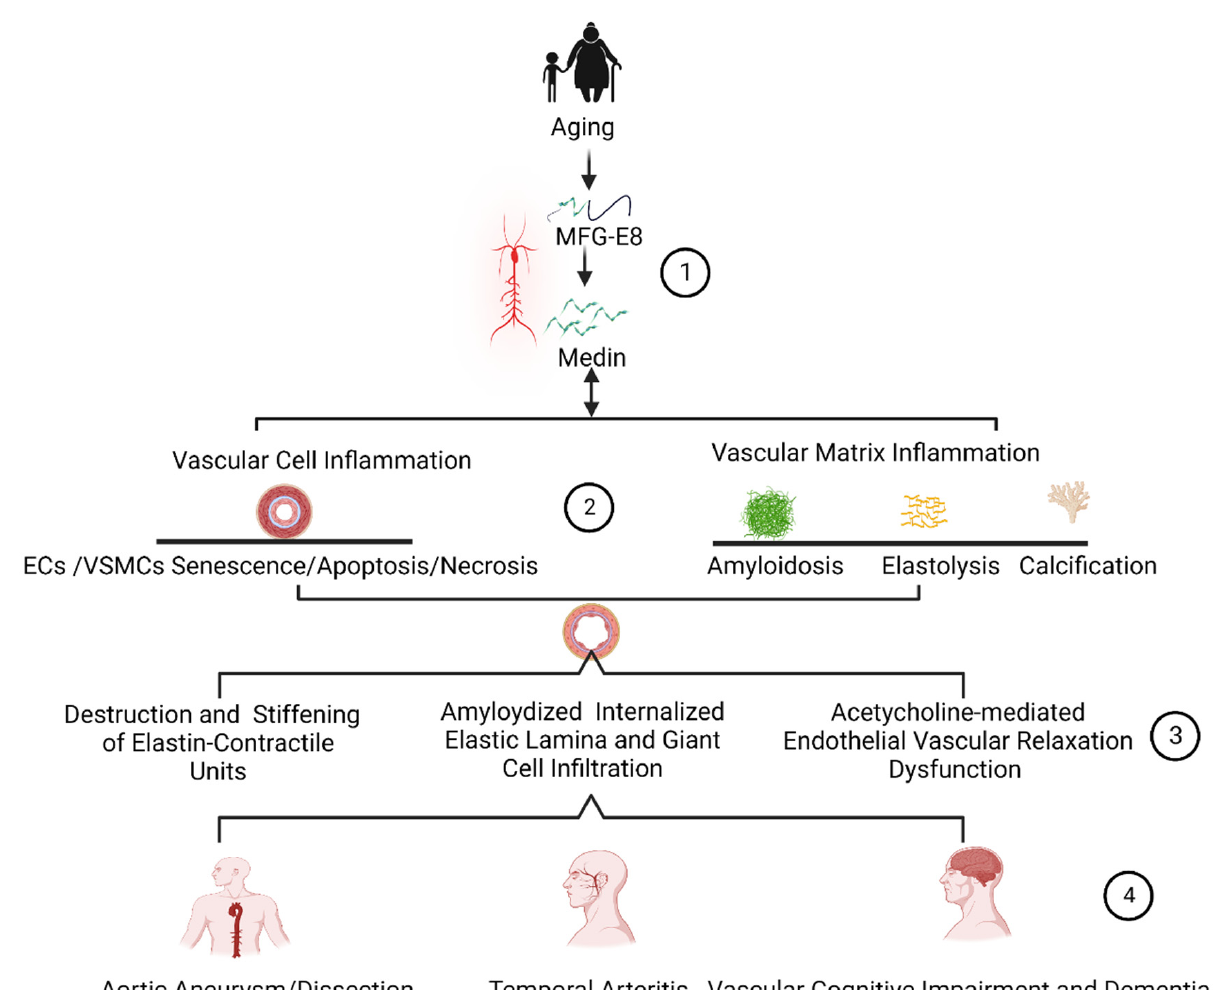
Figure 5. The Role of MFG-E8 Fragment Medin in Age-Associated Arterial Disease. (1) Aging increases MFG-E8 and its fragment medin during inflammatory remodeling; (2) Medin drives the inflammatory phenotypic shifts of ECs and VSMCs, and medin inflammation modifies the vascular extracellular matrix such as through amyloidosis, elastic fragmentation, and calcification; (3) Medin inflammatory signaling promotes vascular wall weakness, endothelial-dependent relaxation de- cline and arterial stiffening; (4) Medin is involved in the development of vascular diseases, aortic aneurysm/dissection, arteritis, and vascular dementia. MFG-E8, milk fat globule EGF VIII; EC, endothelial cells; VSMCs, vascular smooth muscle cells. Created with BioRender.com.